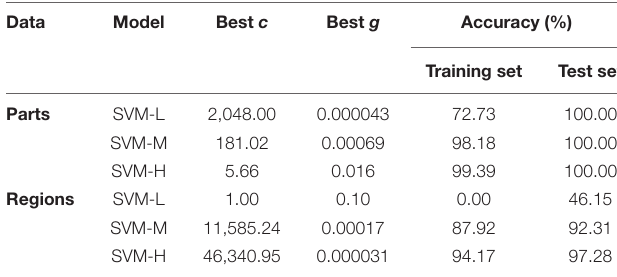
TABLE 2 | The accuracy of SVM models for parts and regions identification based on three levels of data